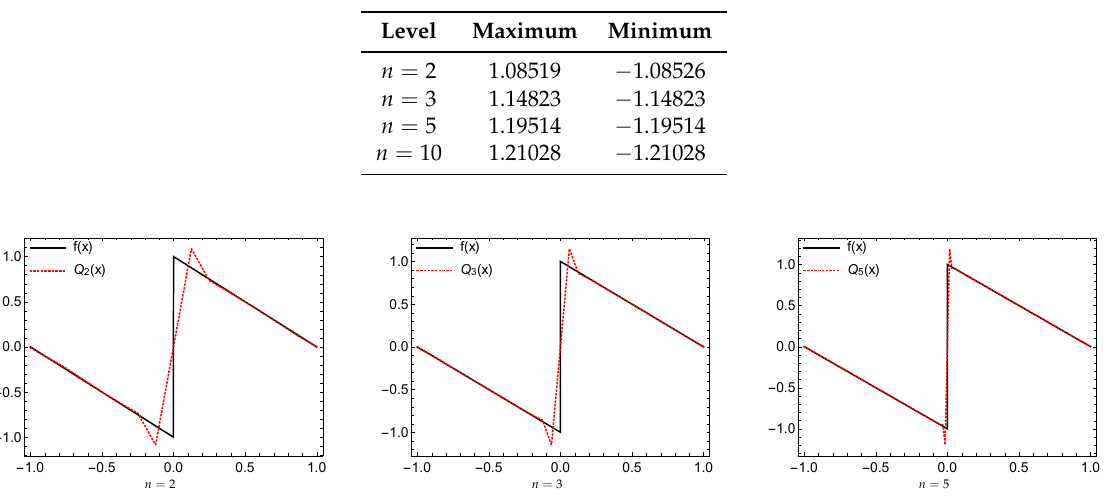
Figure 13. Illustration of the Gibbs effect using the quasi-operator Q n f of Example 4.